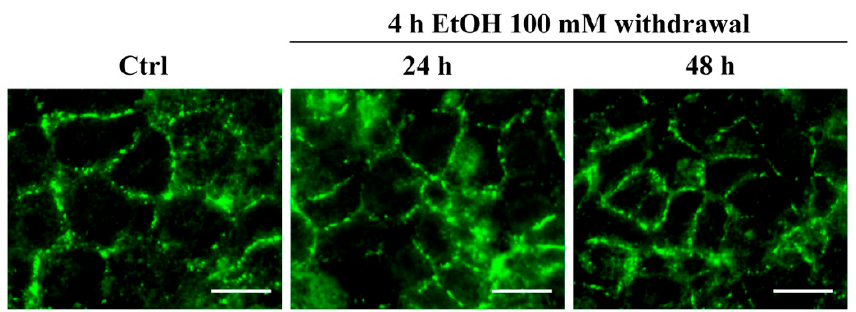
Figure 9. ZO-1 immunofluorescent staining on RBE4 cells after EtOH withdrawal. The ZO-1 staining pattern of distribution evaluated after EtOH withdrawal showing a normal pattern of distribution. Scale bar: 25 µm.